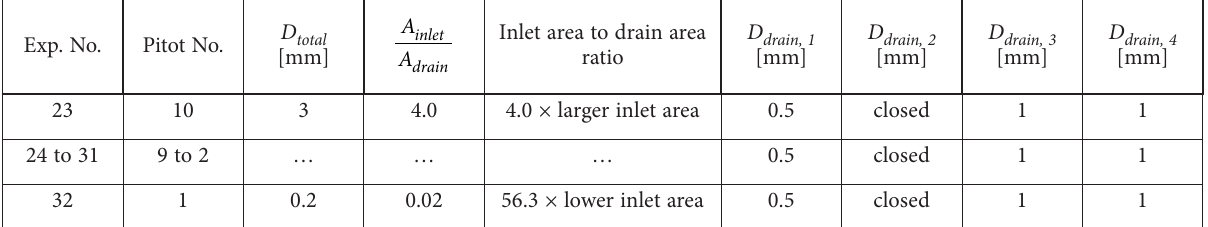
Table 4. Experiments with one 0.5 mm drain hole and two 1 mm drain holes opened 25, 35, 50 and 60 m/s Exp.